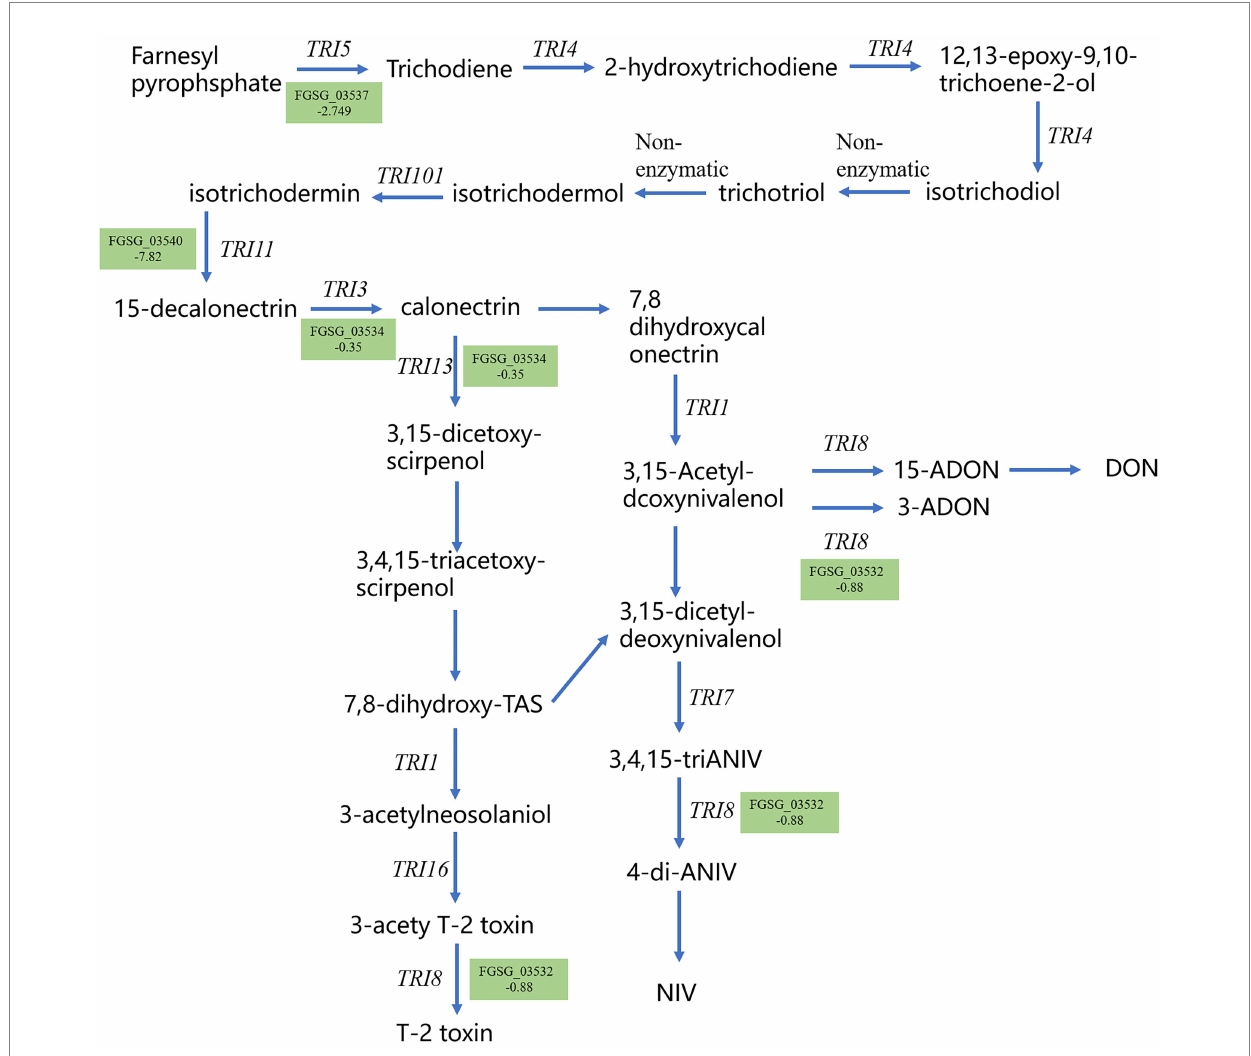
FIGURE 9 Gene expression for the trichothecene mycotoxin metabolism pathway. Gene names in green indicate downregulated gene expression; number represents the fold decrease.